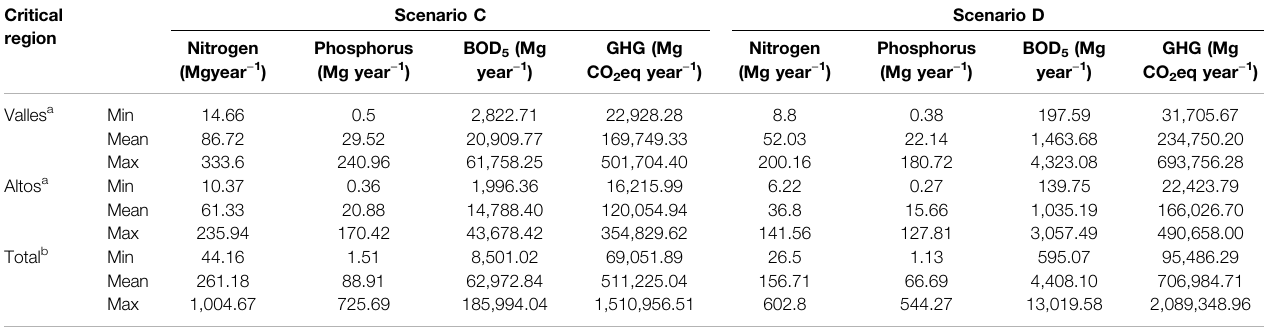
TABLE 9 | Pollutant discharge potential values calculated for the established critical regions under scenarios C and D. Critical